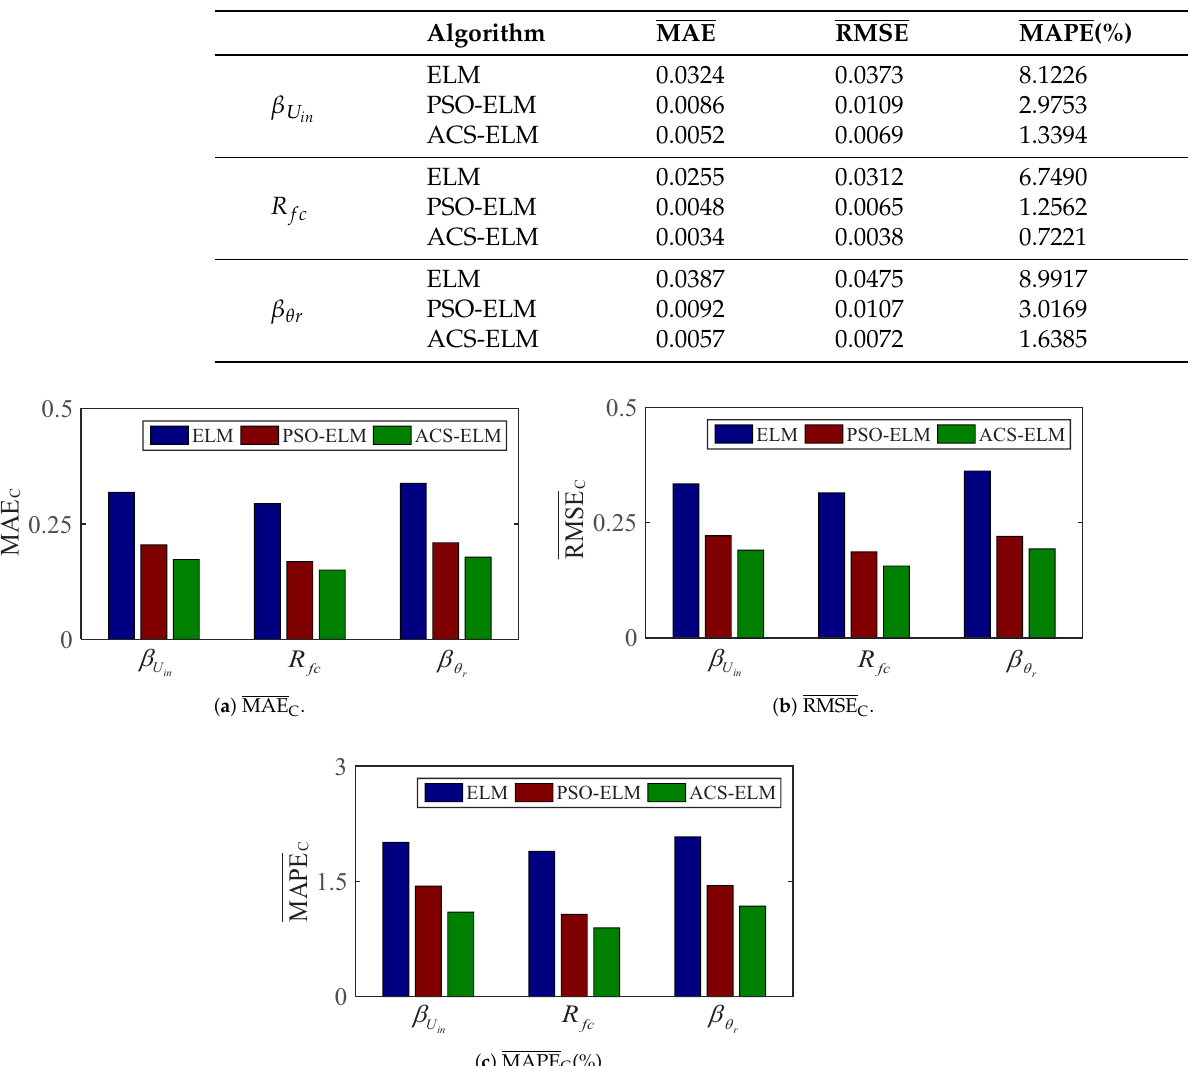
Table 6. Comparison of RUL prediction performance.